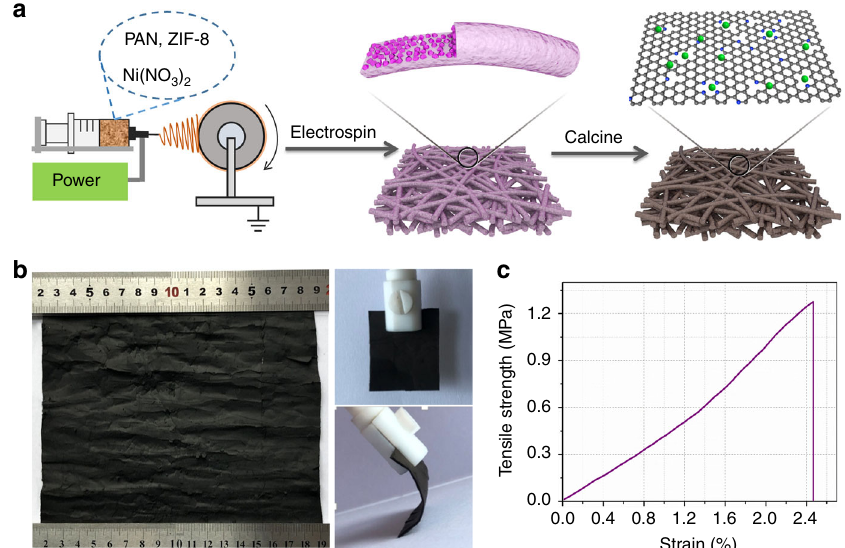
Fig. 1 Physical characterizations of NiSA/PCFM. a Synthesis strategy of NiSA/PCFM. b Digital images and c stress-strain curve of NiSA/PCFM membrane.